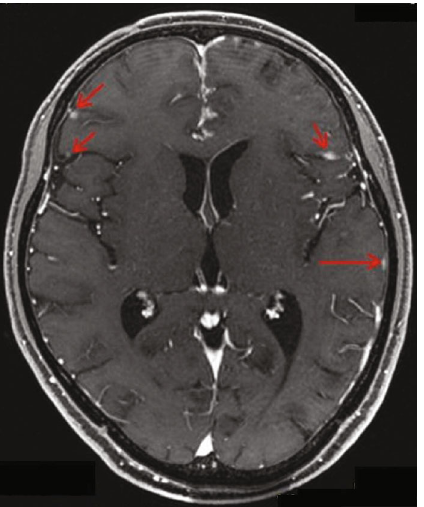
Figure 4: T2-weighted magnetic resonance imaging revealed multiple leptomeningeal metastases at bilateral trigeminal, facial, and abductor nerves and surrounding tissues of the brain stem and cervical spinal cord